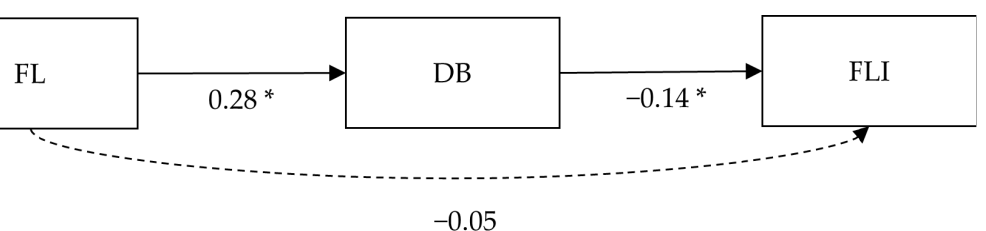
Figure 1. Simplified version of the path analysis. Note: * p < 0.05; FL = food literacy, DB = dietary behavior, FLI = fatty-liver index, insignificant paths are displayed in dashed arrow lines, control variables are not displayed in this figure. Table 3. Standardized path coefficients, SEs, and 95% CIs for the path